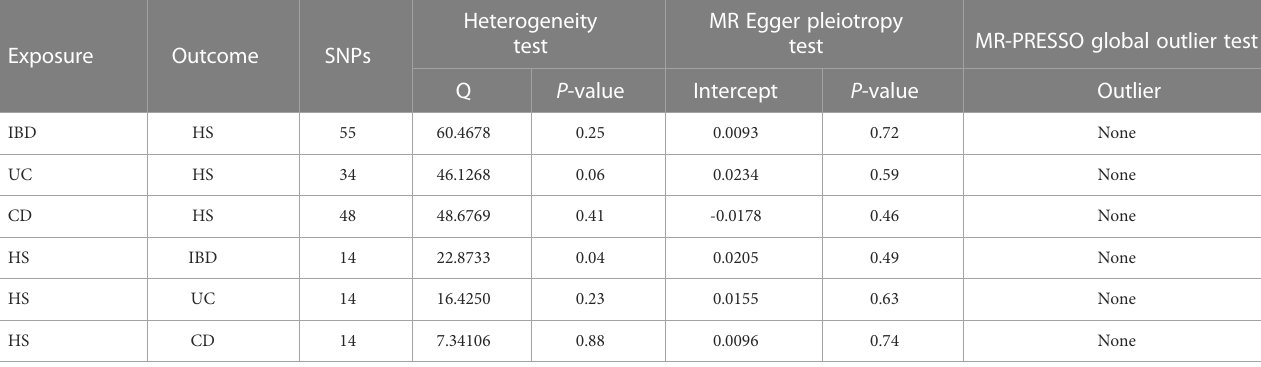
TABLE 1 Sensitivity analyses of